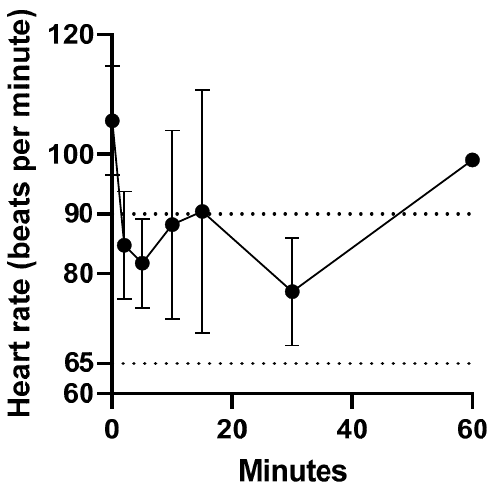
Figure 1. Mean ± S.D heart rate on administration of fentanyl 5 µ g/kg as a single i.v. bolus over the first hour. Normal koala heart rate (bpm) is within dotted lines. There was only a significant difference in mean heart rate between 0 and 2 minutes ( p = 0.04).